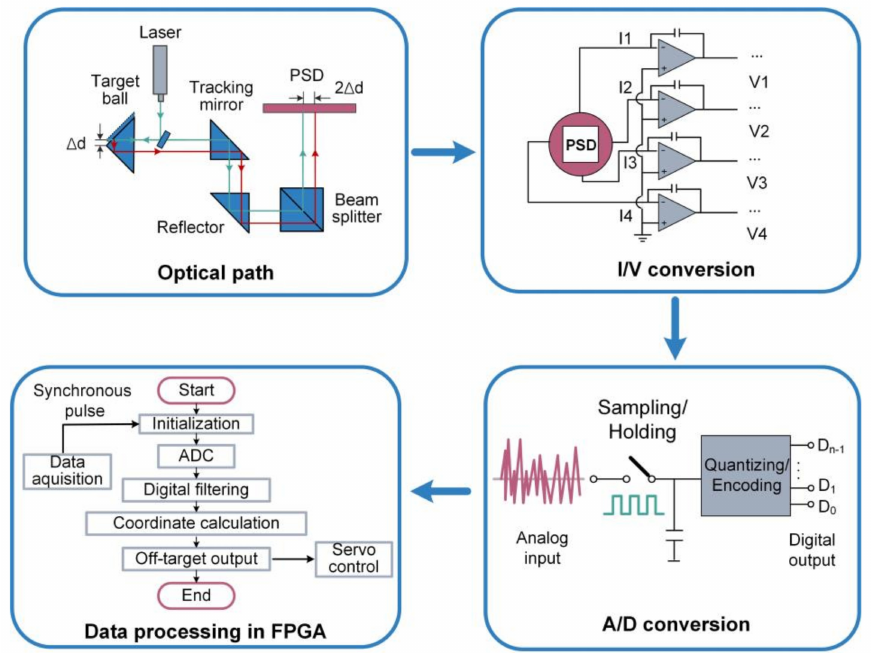
Figure 3. Block diagram of miss distance measurement